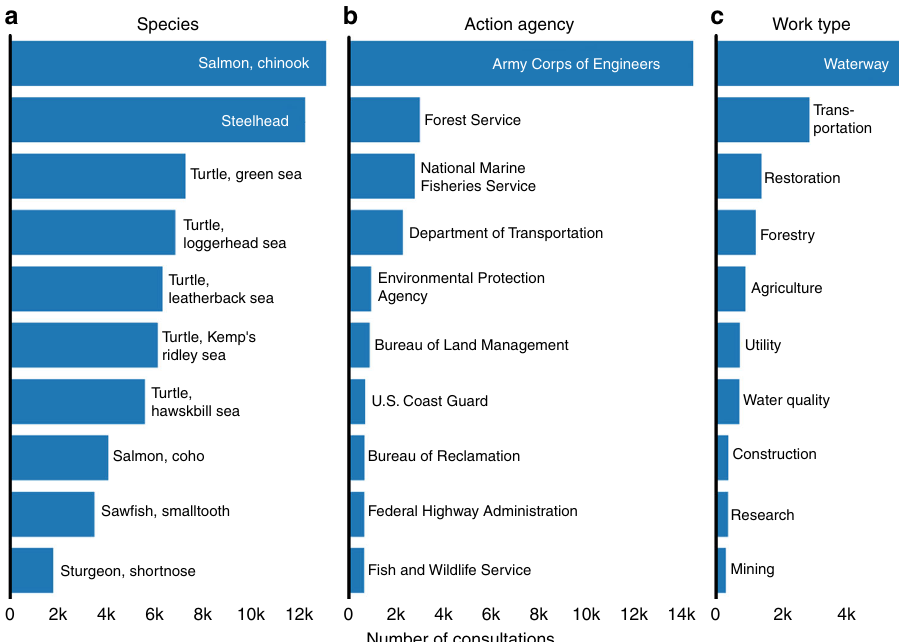
Fig. 1 Frequencies of U.S. Endangered Species Act section 7 consultations conducted by the National Marine Fisheries Service involving different species ( a ), federal action agencies ( b ), and work types ( c ) between 2000 and 2017. The ten most frequent members of each group are shown. Species listed from top to bottom are Oncorhynchus tshawytscha, Oncorhynchus mykiss, Chelonia mydas, Caretta caretta, Dermochelys coriacea, Lepidochelys kempii, Eretmochelys imbricata, Oncorhynchus kisutch, Pristis pectinate, Acipenser